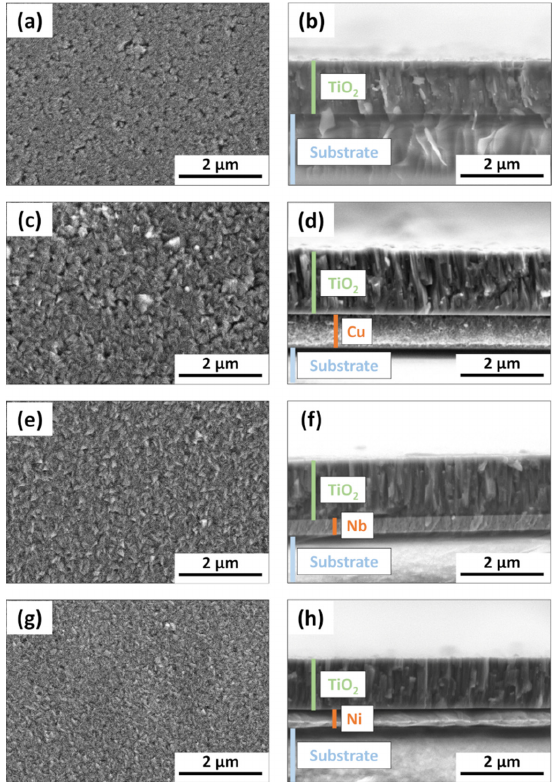
Figure 2. SEM surface and cross-section views of C-doped TiO 2 films deposited on various underlayers: ( a , b ) no underlayer; ( c , d ) Cu underlayer; ( e , f ) Nb underlayer; ( g , h ) Ni underlayer.